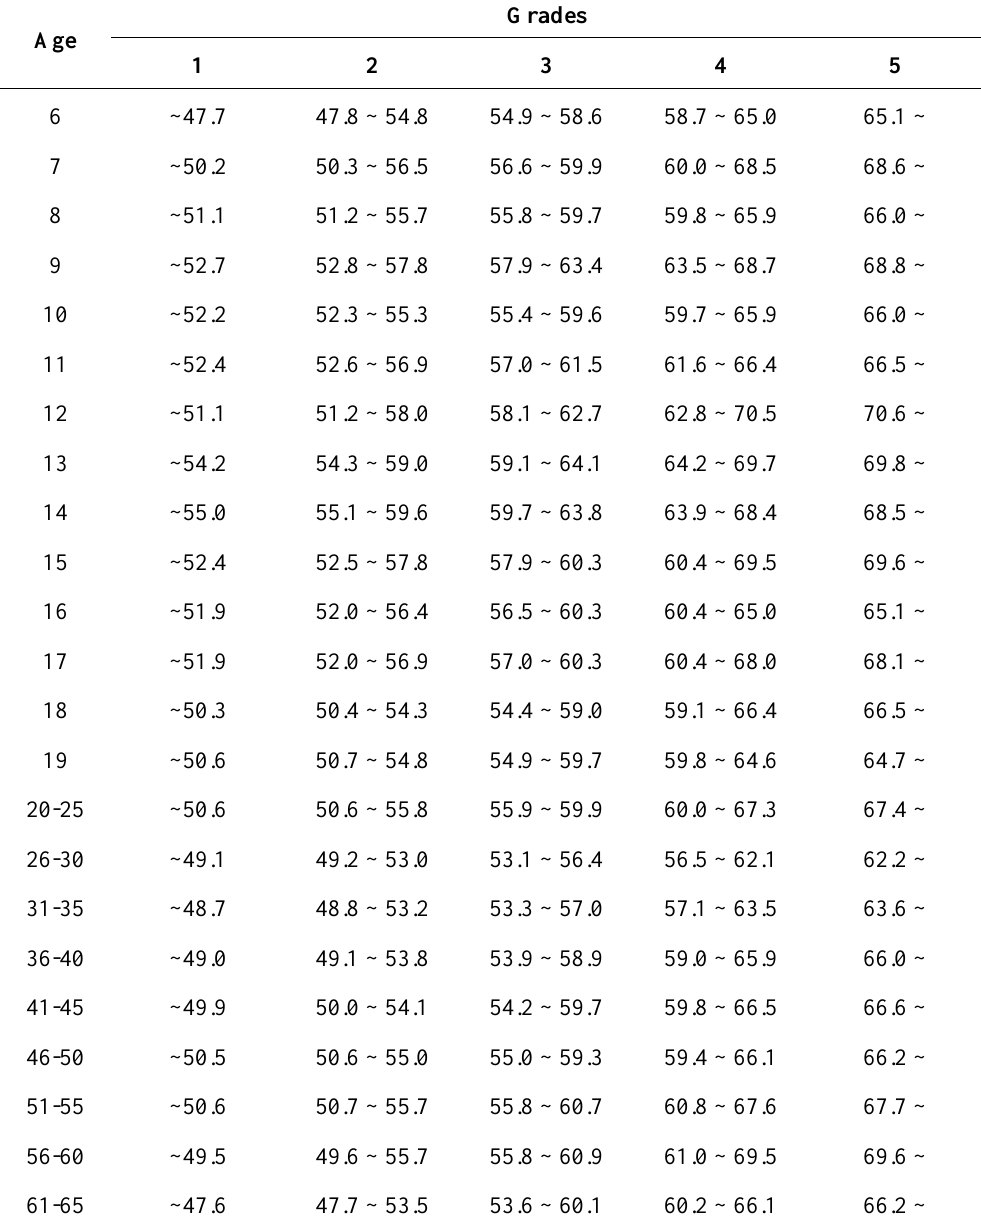
Table 3. Recommended scoring matrix for male‘s ―3 min up and down